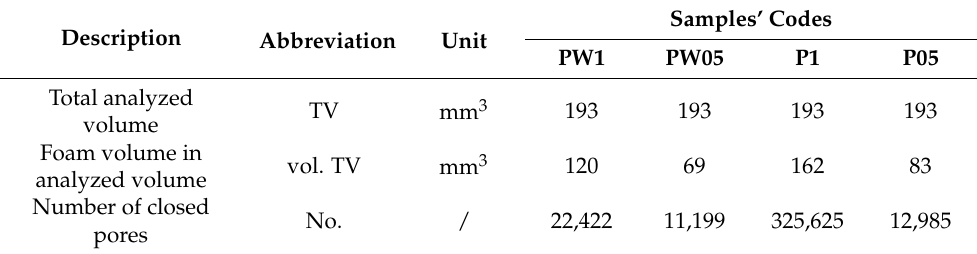
Figure 3. Space cross section of the foam sample: ( a ) PW1; ( b ) PW05; ( c ) P1; ( d ) P05. Table 2. Results from 3D image analysis of